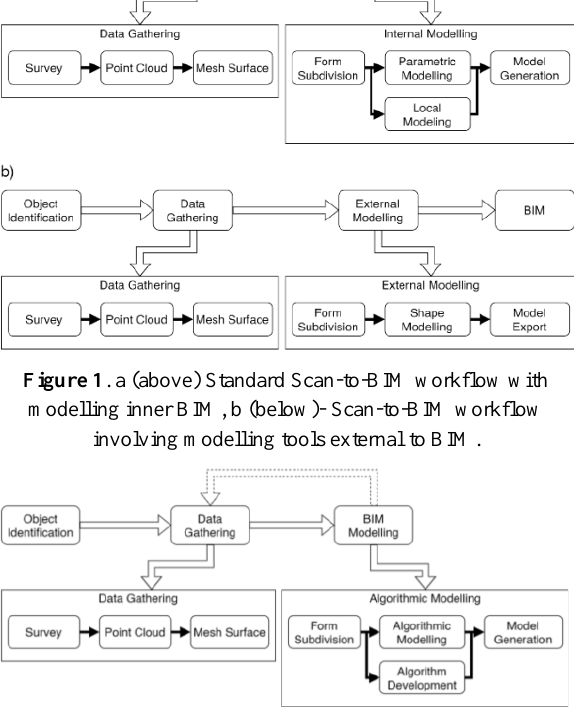
Figure 2 . Scan-to-BIM workflow involving algorithmic modelling tools within the BIM